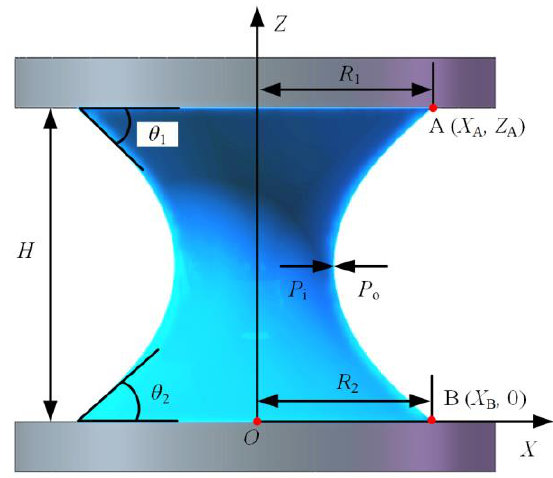
Figure 7. Model of the liquid bridge between